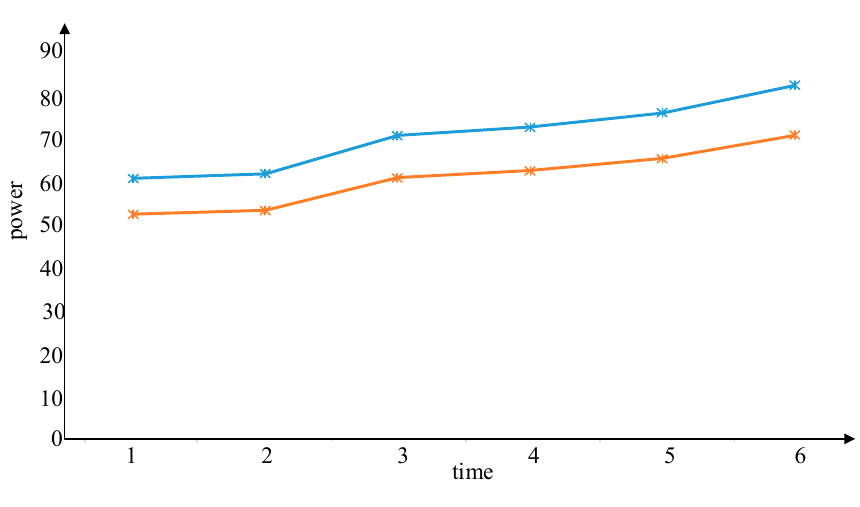
Figure 13. Generation scheme of RG.